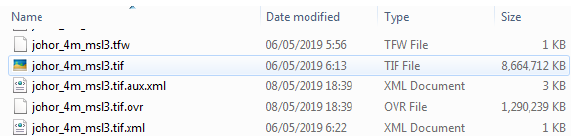
Figure 13; File based consumed more storage capacity